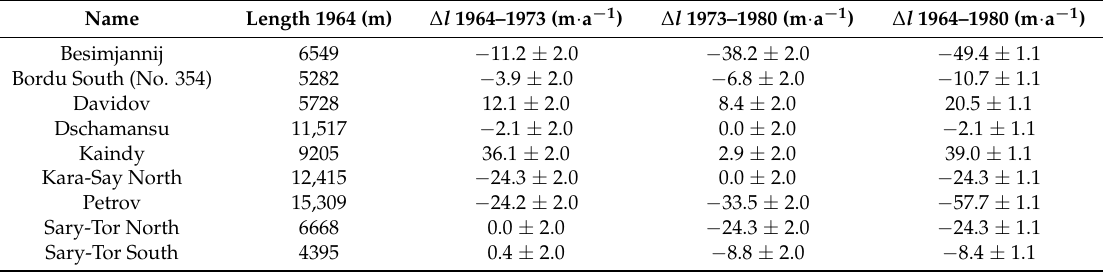
Table 5. Total glacier lengths and length changes for individual glaciers over three different